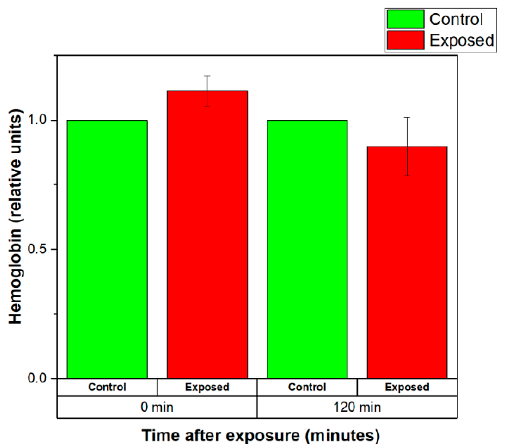
Figure 11. Normalized levels of the hemoglobin released by the control (sham-exposed) and exposed erythrocyte suspensions for 20 min to 2.41 GHz (WSA SAR = 29.6325 W/kg, psSAR1g = 41.13 W/kg, wearable antenna input power 450 mW, Zigbee-like signal). The mean of 4 experiments ± SEM is shown.